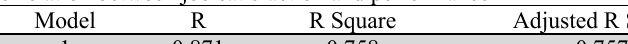
Correlation between job satisfaction and performance